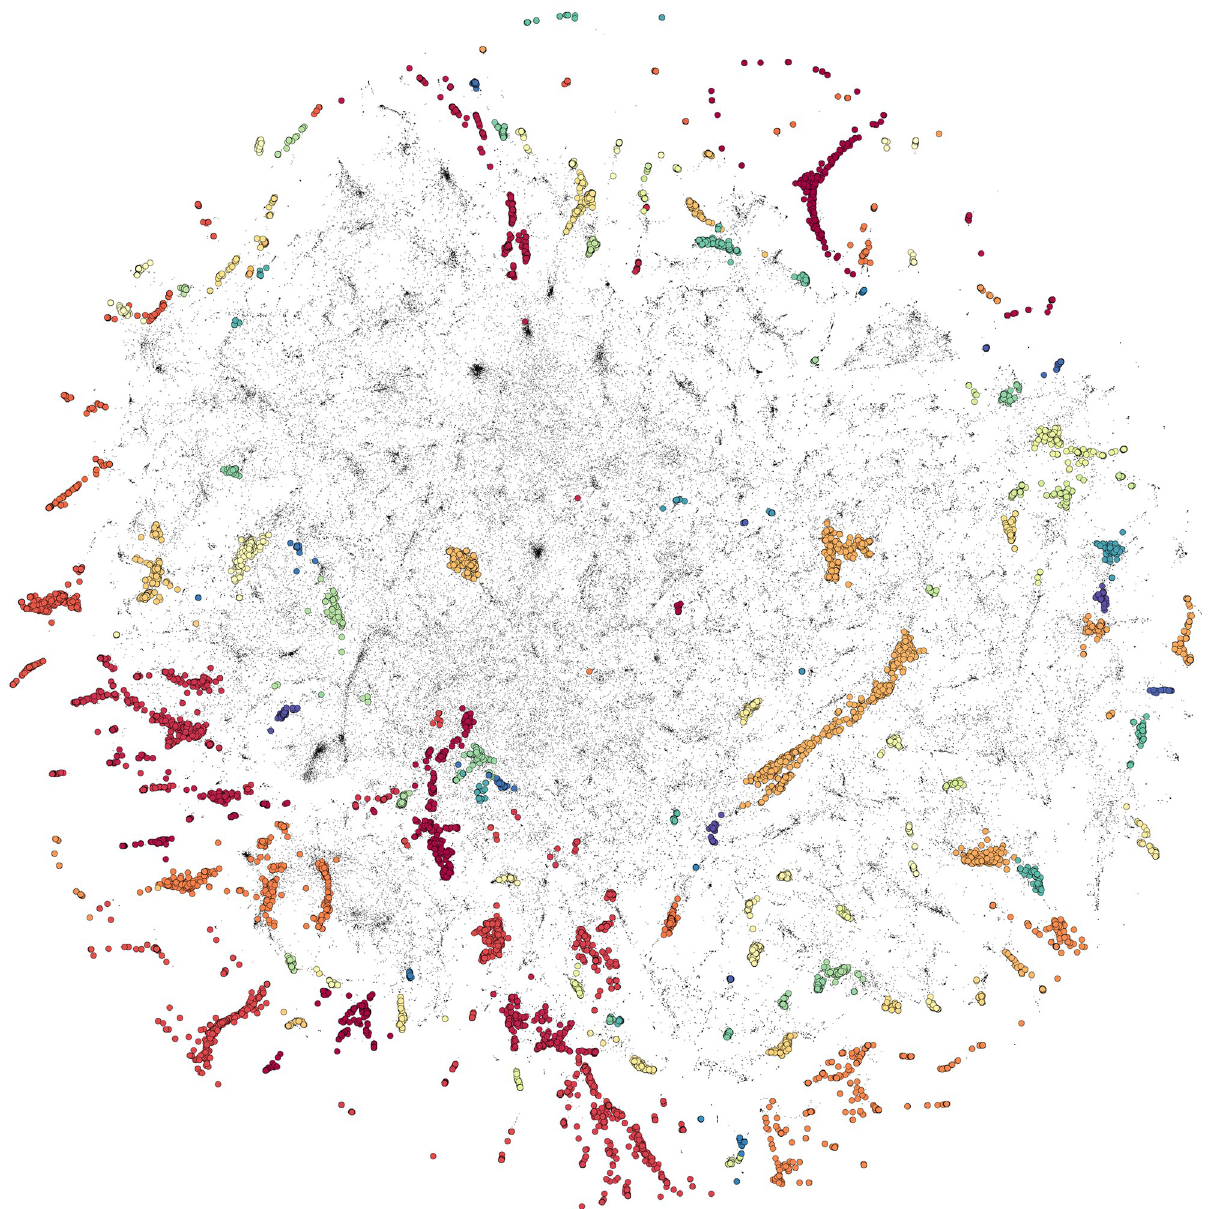
Fig 2. t-SNE projection of 206 K package leaflet sentence embeddings, showing 129 clusters in colour coding and non-clustered sentences in black.